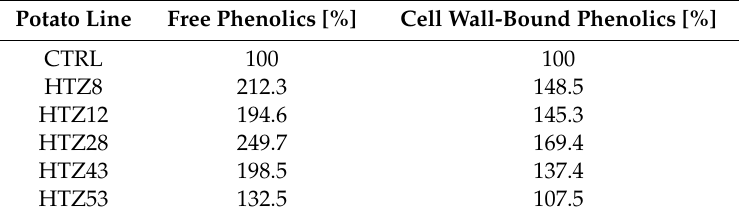
Table 1. Total phenolic content assayed in the transgenic HTZ lines in the methanolic extracts (free phenolics) and after hydrolysis (cell wall-bound phenolics) compared to the control (CTRL). Potato Line Free Phenolics [%]